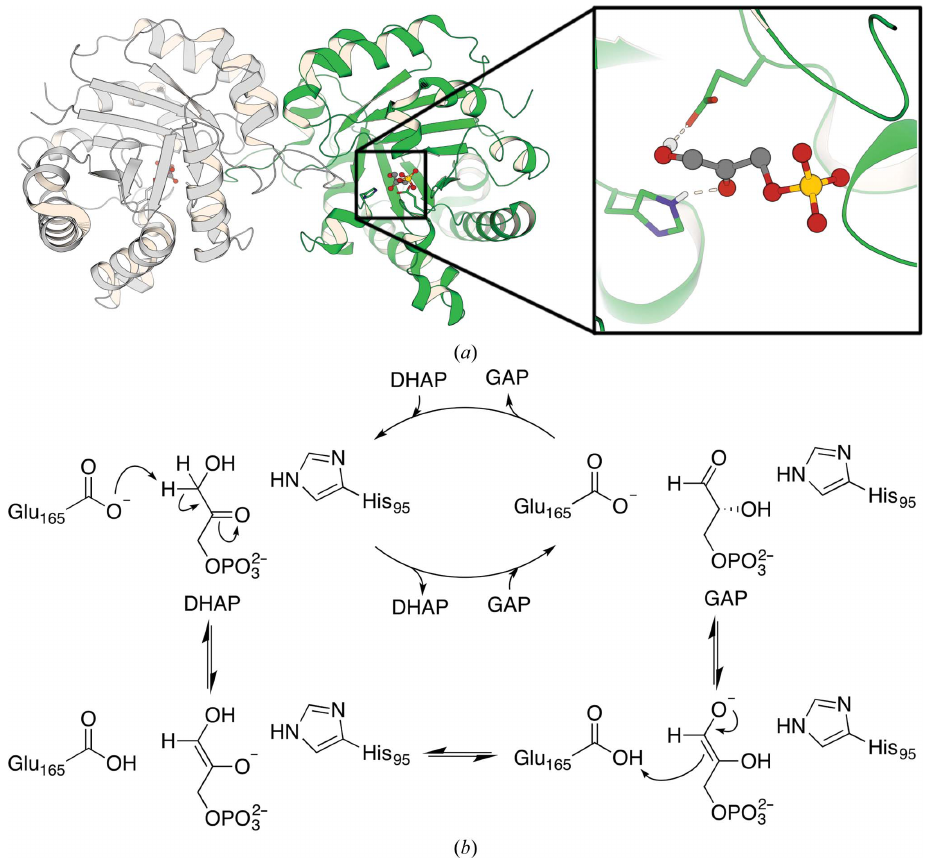
Figure 6 ( a ) Left, an overview of the structure of triosephosphate isomerase from S. cerevisiae (PDB entry 1ney; Jogl et al. , 2003) in complex with DHAP (displayed in ball-and-stick representation and coloured dark grey). Right, a close-up view of the active site, with highlighted key catalytic residues His95 and Glu165 and the substrate DHAP. Chain A is coloured green and chain B light grey. ( b ) The proposed mechanism for the isomerization catalysed by TIM. DHAP and GAP are acronyms for dihydroxyacetone phosphate and ( R )- glyceraldehyde 3-phosphate, respectively. This mechanism is based on Wierenga et al. (2010) and Richard